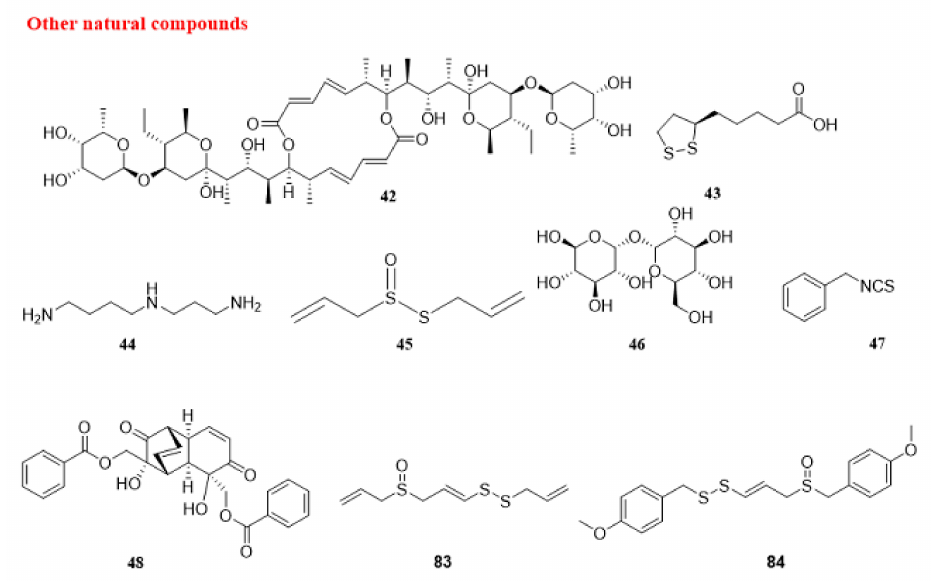
Figure 13. Chemical structures of unclassified natural compounds with anti-cancer activity. Elaio- phylin (42), lipoic acid (43), spermidine (44), allicin (45), trehalose (46), benzyl isothiocyanate (47), (+)-grandifloracin (48), ajoene (83), bisPMB (84). The images were prepared using ChemDraw Professional